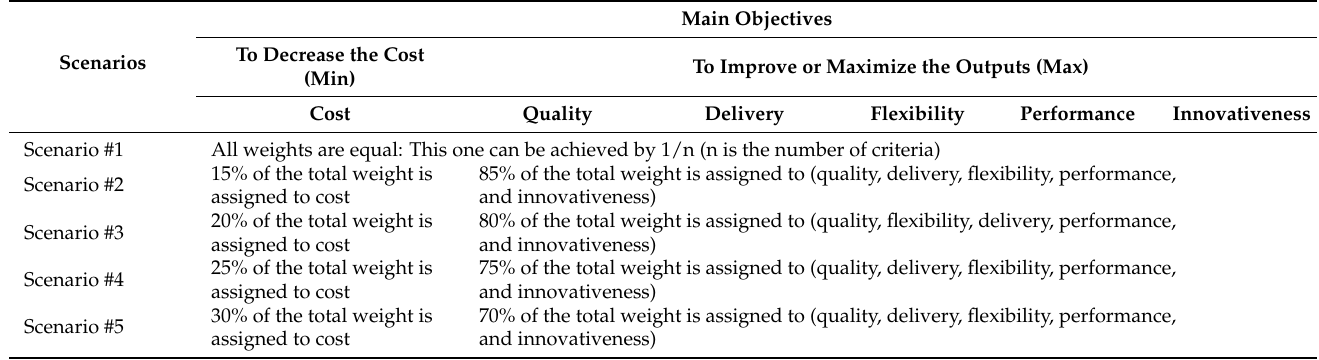
Table 9. The configuration of sensitivity analysis.